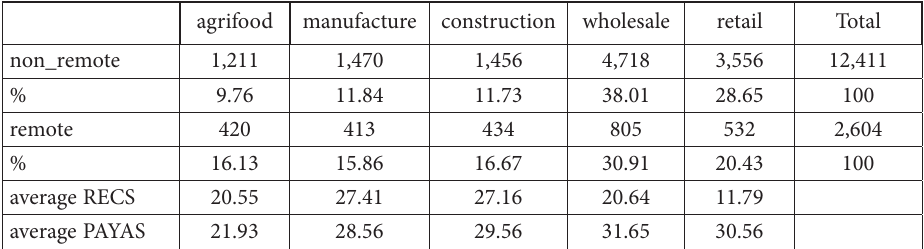
Table 2. Number of observations and average trade credit figures by economic sector